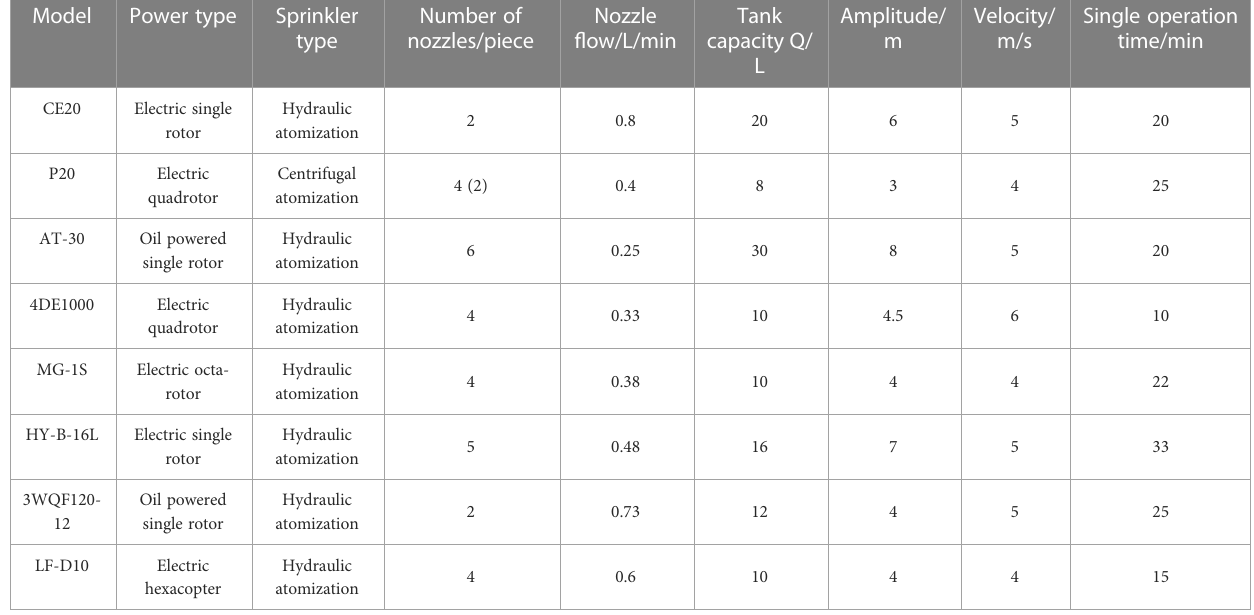
TABLE 2 Basic parameters of plant protection UAV participating in the